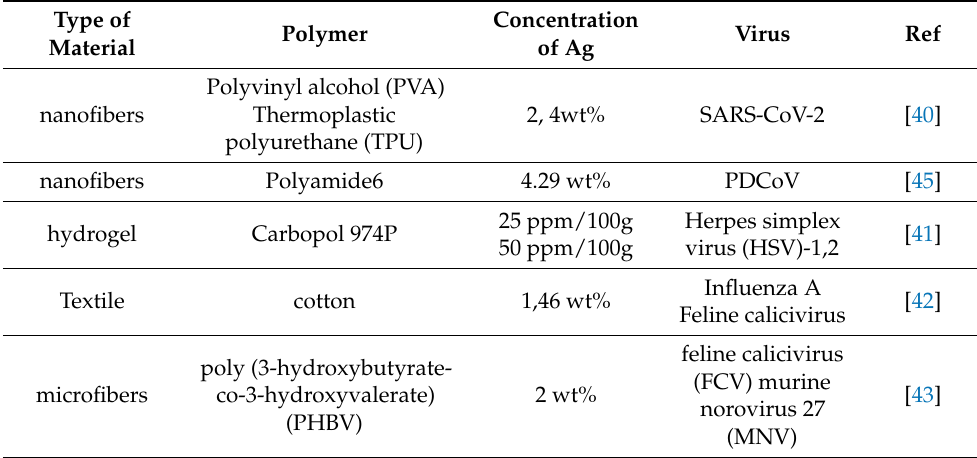
Table 3. Antiviral efficiency of Ag-contained